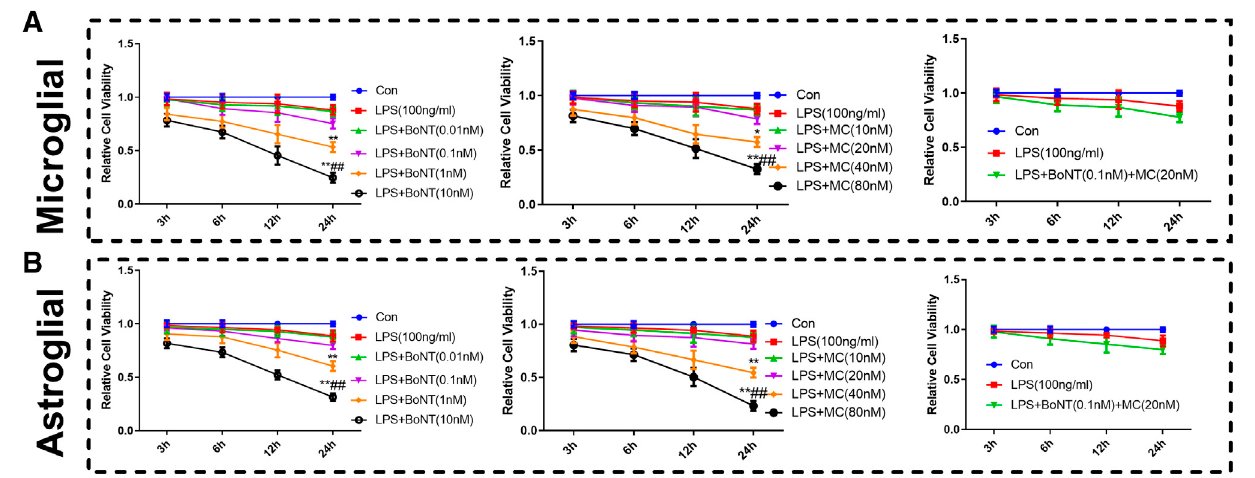
FIGURE4| EffectofBoNTandMCcombinationontheproliferationofmicrogliaandastrocytes. (A-B) CCK8wasconductedtodetecttheeffectsofBoNTandMC combination on the proliferation of microglia and astrocytes (* p < 0.05, ** p < 0.01, *** p < 0.0001 V.S LPS; # p < 0.05, ## p < 0.01, ### p < 0.0001 V.S LPS + BoNT or and LPS + MC, N (cid:2)